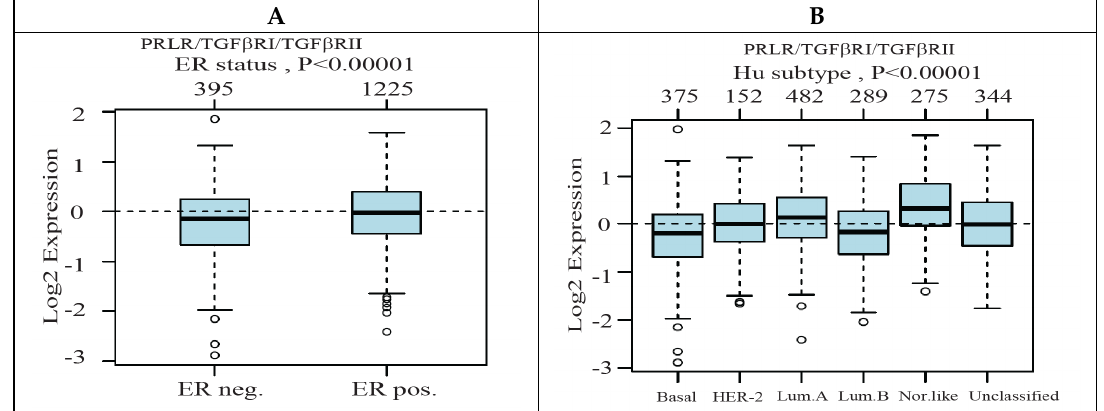
Figure 4. The expression level of PRLR/TGFβRI/TGFβRII gene signature and its association with estrogen receptor (ER) status and breast cancer molecular subtypes. ( A ) Boxplot of PRLR/TGFβRI/TGFβRII gene signature in 1881 breast cancer cases from the GOBO database stratified according to ER status. The band inside the box represents the median and the top and bottom of the box indicate the distance between the quartile 1 (Q1), quartile 3 (Q3) and 1.5 times the interquartile range. The circles indicate the outliers. ( B ) PRLR/TGFβRI/TGFβRII gene signature and its association with breast cancer molecular subtypes (Hu classification) using 1881 breast cancer cases from the GOBO database.